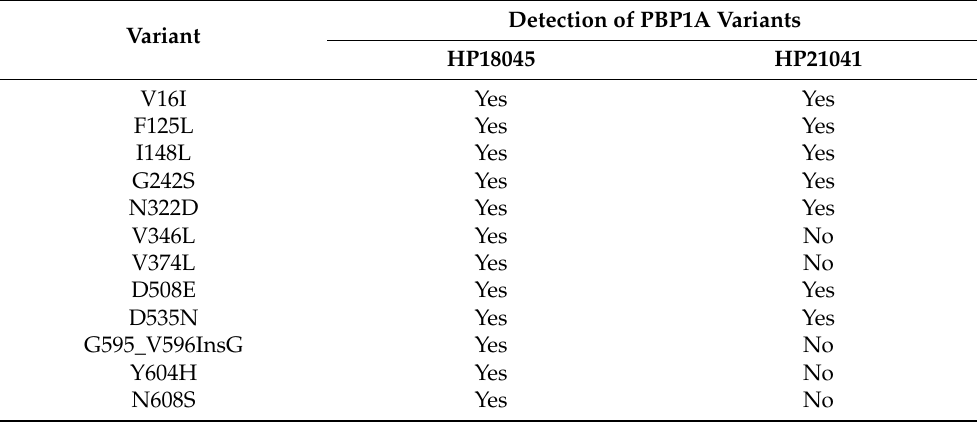
Table 3. List of codon variants detected in amoxicillin-resistance and amoxicillin-susceptible H. pylori strains.